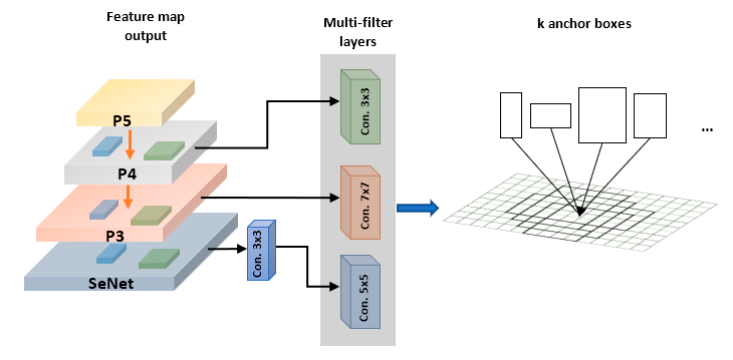
Figure 7. Multi-filter multi-scale region proposal network (RPN) architecture.